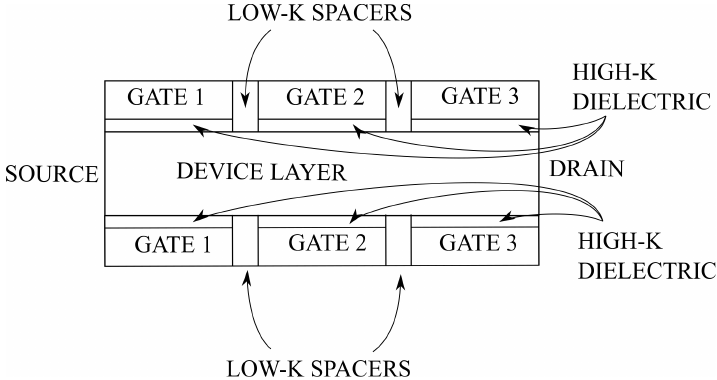
Figure 16. Cross-sectional view of a junctionless tunnel field effect